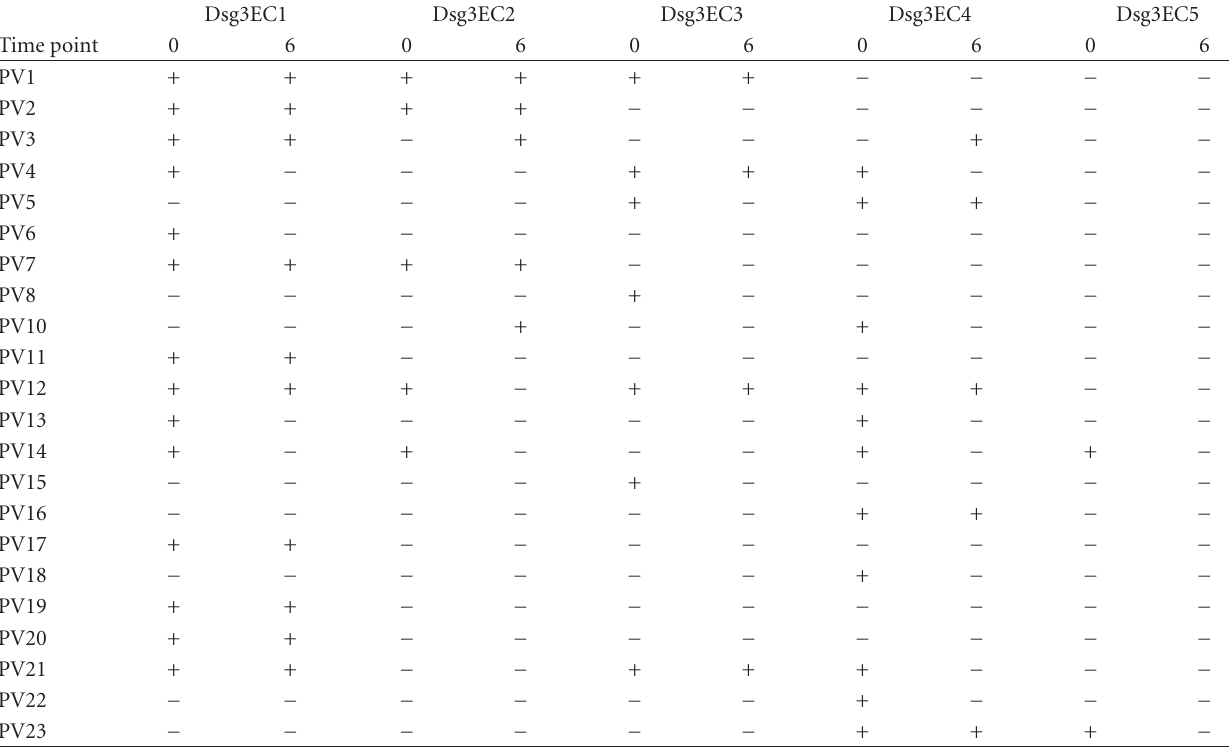
Table 2: Profile of desmoglein 3 (Dsg3)-specific IgG autoantibodies of the pemphigus vulgaris (PV) patients before and 6 months after treatment with rituximab (Rtx).